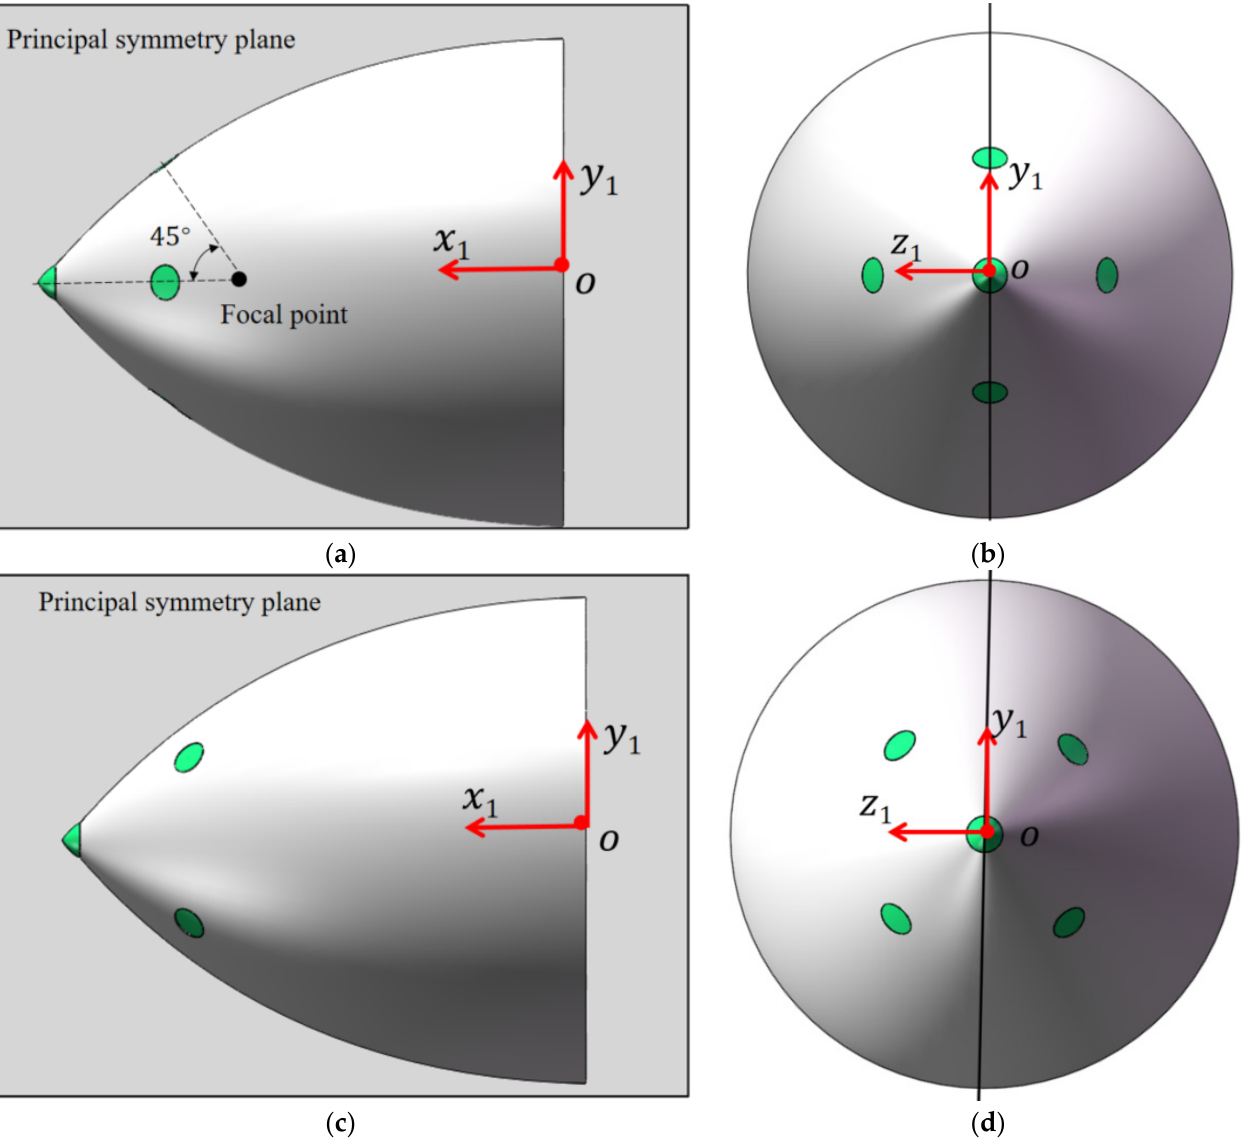
Figure 1. Sensor layout diagrams. ( a ) Left view of +-shaped layout. ( b ) Front view of +-shaped layout. ( c ) Left view of X-shaped layout. ( d ) Front view of X-shaped layout.